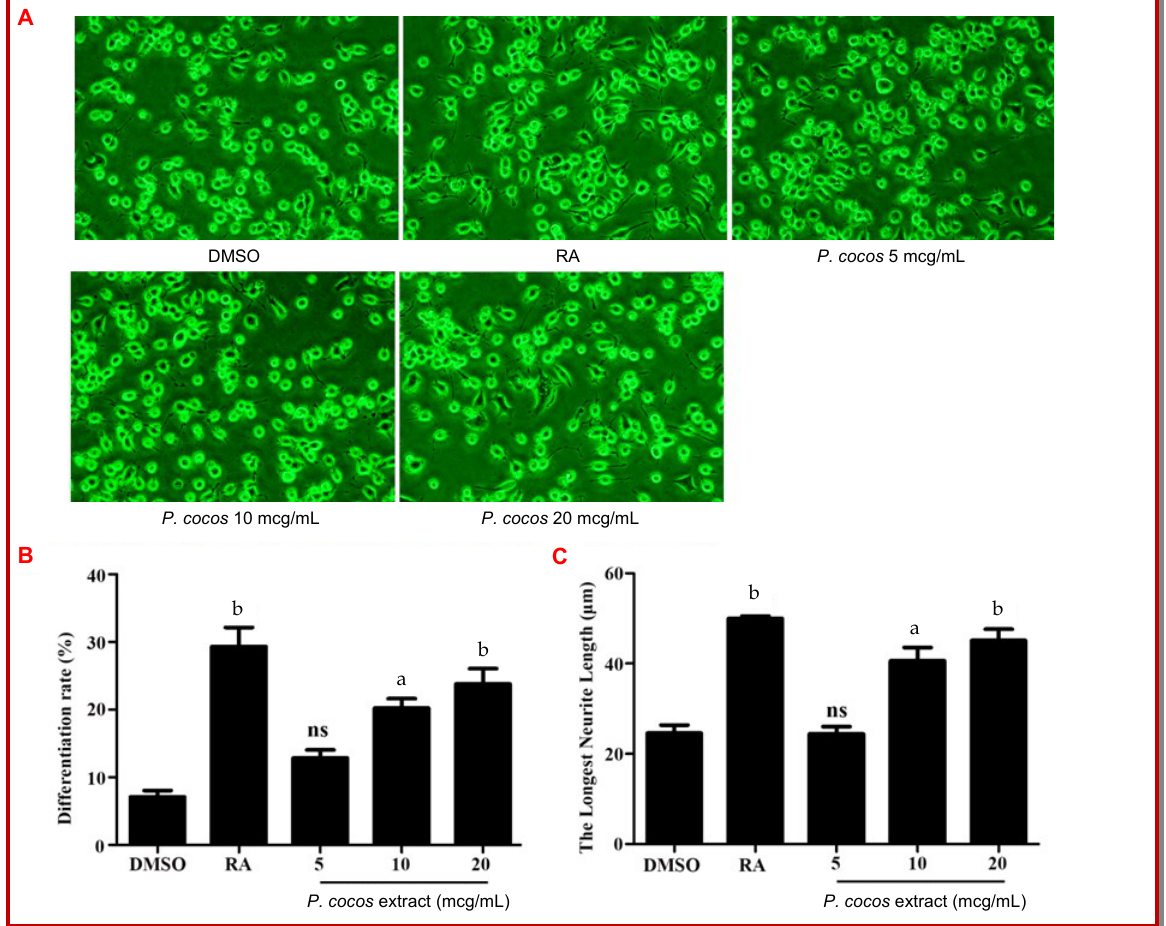
Figure 4: P. cocos promotes differentiation of Neuro-2a cells. Cell morphology is shown after Neuro-2a cells were treated with RA, various concentration (5-10 μ g/mL) of P. cocos for two days (A). The changes in the differentiation rate (B) and the longest neurites length (C) in Neuro-2a cells treated with various concentrations (5-10 μ M) of P. cocos . a p<0.01, b p<0.001, NS, not statistically signifi- cant. Student’s t -test. At least 300 cells/group were analyzed in each experiment, n=3. Error bars,